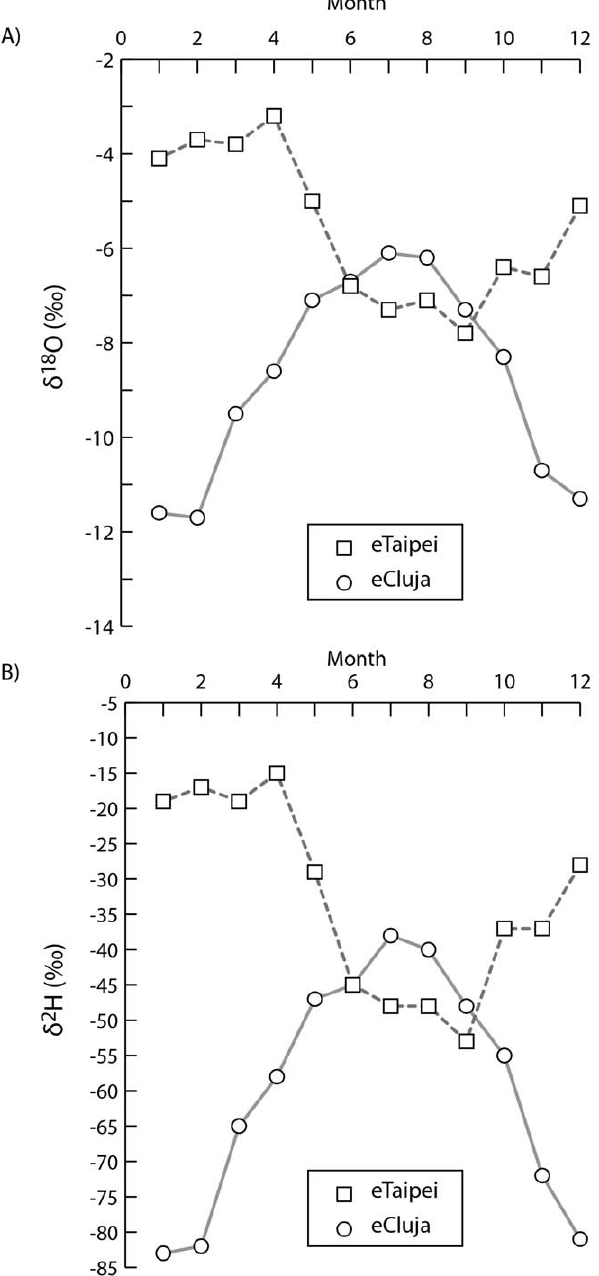
Figure 3. The stable isotopes of monthly precipitation in Taipei, Taiwan and in Cluj-Napoca, Romania. Shown is the estimated stable isotope of monthly precipitation, generated by using algorithm, developed by Bowen et. al. [12,37]. The square denotes the estimated isotope of monthly precipitation in Taipei with settings of latitude 25 u , longitude 121.5 u , and altitude 10 m. The circle denotes the estimated isotope of monthly precipitation in Cluj-Napoca with settings of latitude 46.7 u , longitude 23.6 u , and altitude 335 m.